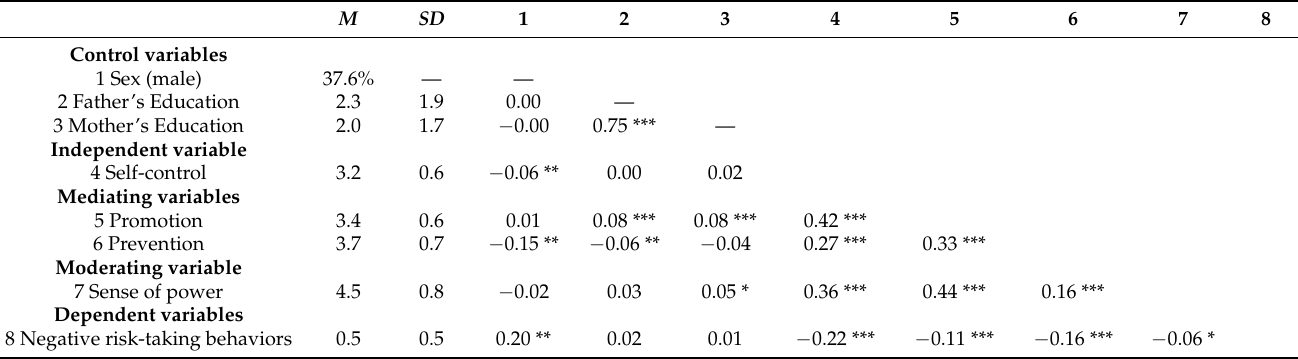
Table 1. The means, standard deviations, and bivariate correlations of the study